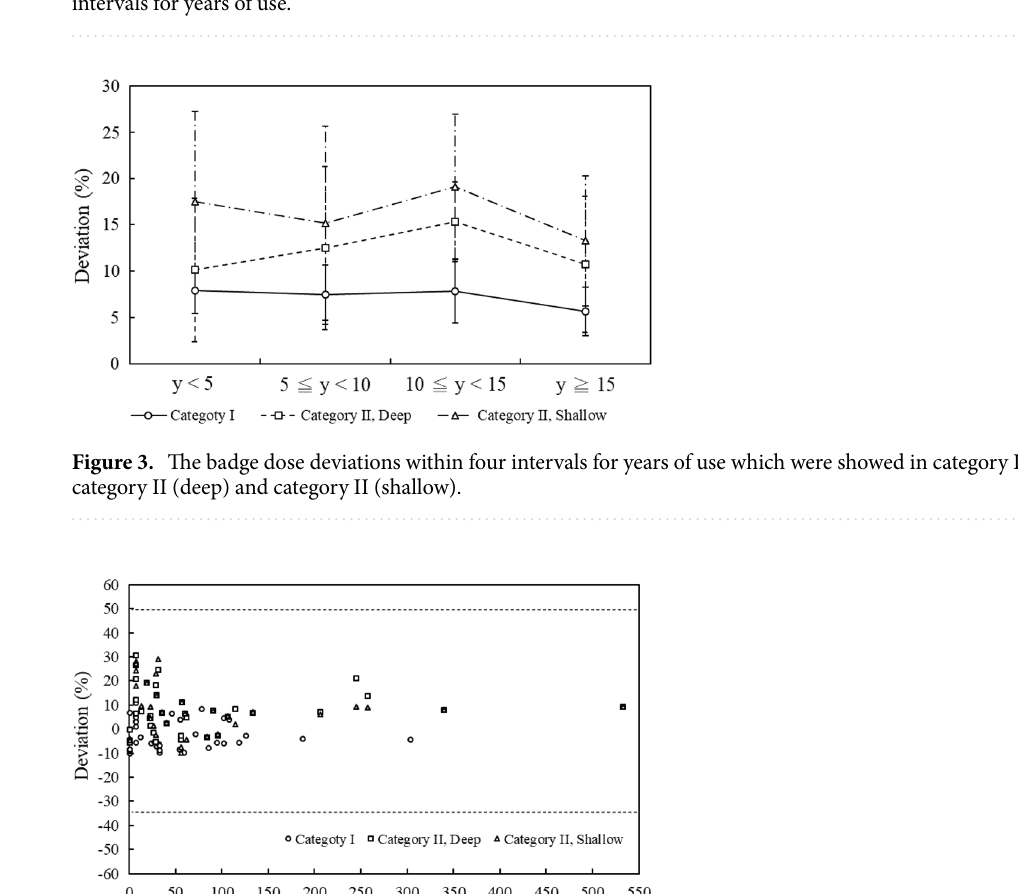
Figure 2. The average frequency of readout procedure in blind test personal badges corresponded to four intervals for years of use.